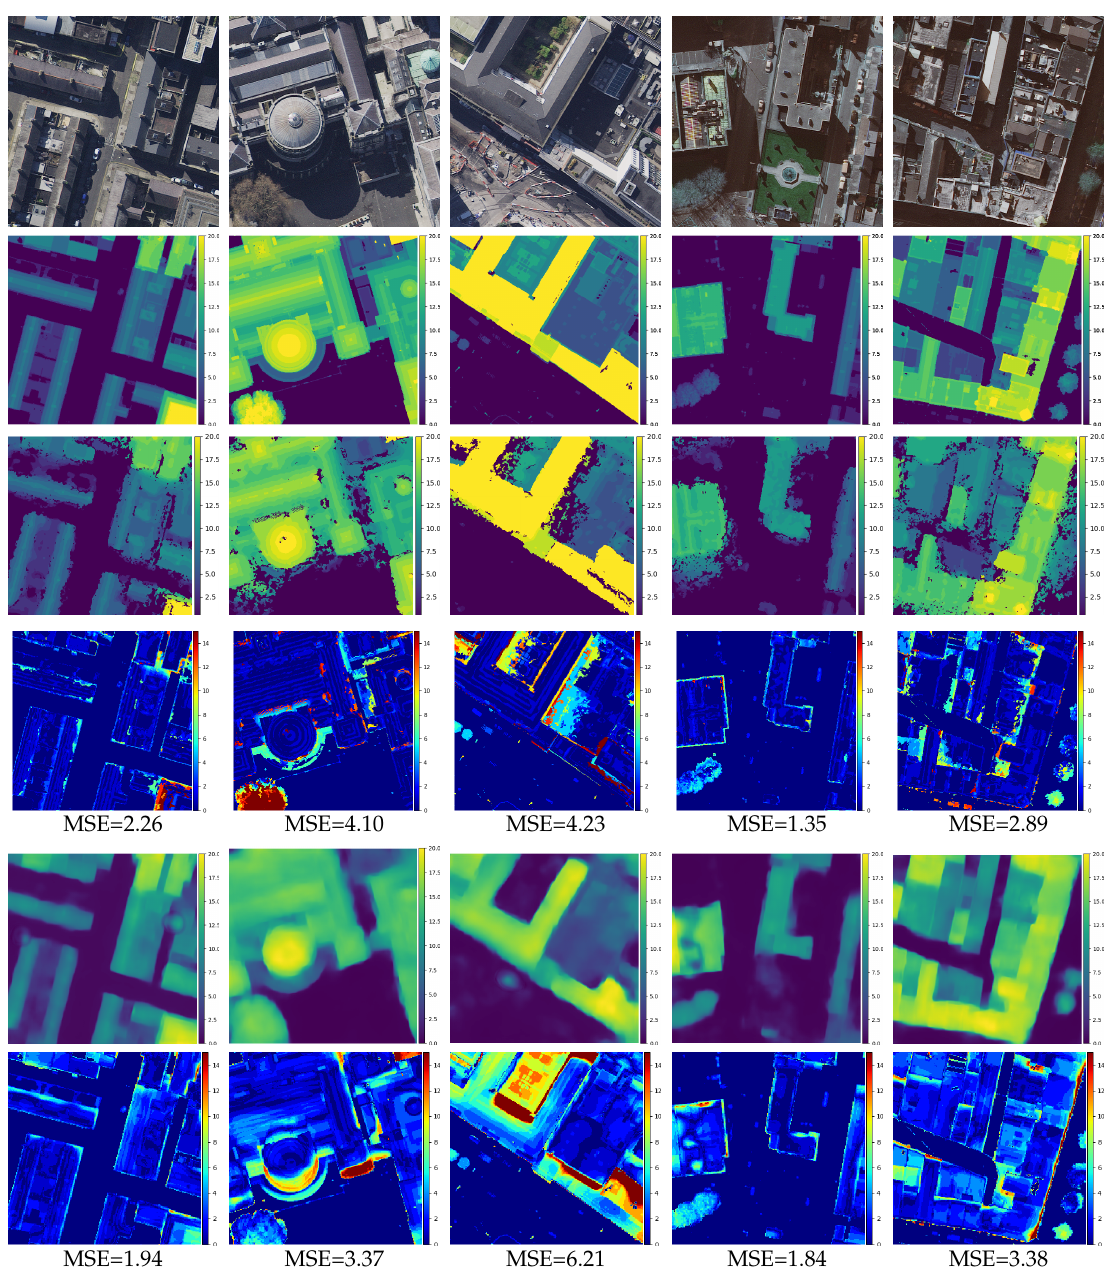
Figure 11. DSM from stereo imagery (source Ordnance Survey Ireland (OSI)) vs. DSM from IM2ELEVATION. From top to bottom (rows 1–6): (1) aerial image input, (2) ground truth DSM, (3) DSM generated from stereo images, (4) heat map of the difference between (2) and (3), (5) DSM from IM2ELEVATION, and (6) heat map of the difference between (2) and (5). Color scale is in meters. Note the strong impact of a tree canopy in the second column sample with IM2ELEVATION DSM reconstructing this element